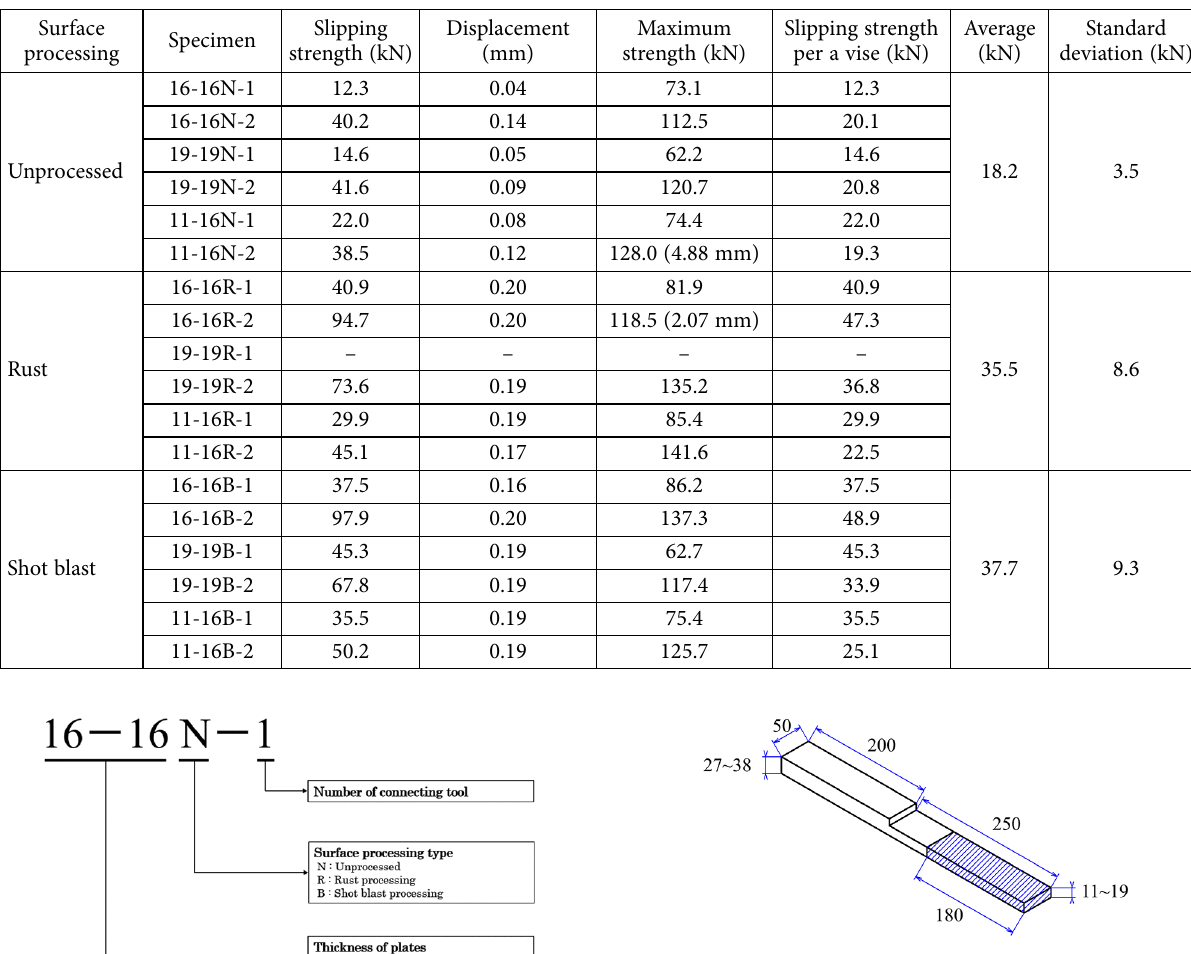
Table 1. Test specimens for tensile test